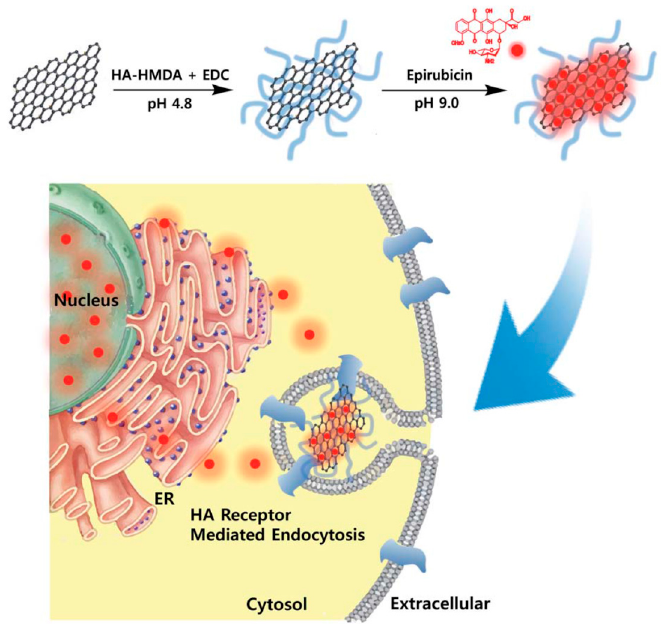
Figure 5. The preparation process of epirubicin/NGO- hyaluronic acid (HA) nanohybrid and the mechanism of drug controlled release. NGO: nanoscale gaphene oxide. Reproduced with permission from [49]. Copyright Royal Society of Chemistry, 2014. Appl. Sci. 2017 , 7 , 1175